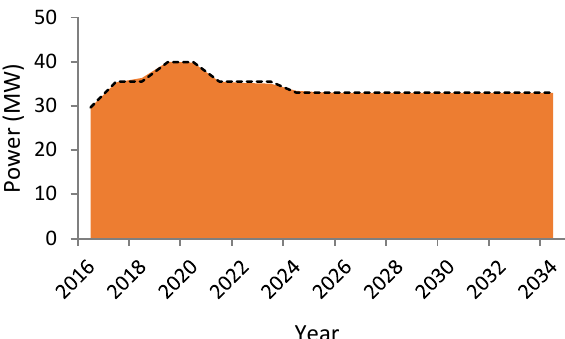
Figure 3. Lifetime power demand of the installation. The dashed line represents an approximation of the power demand profile.